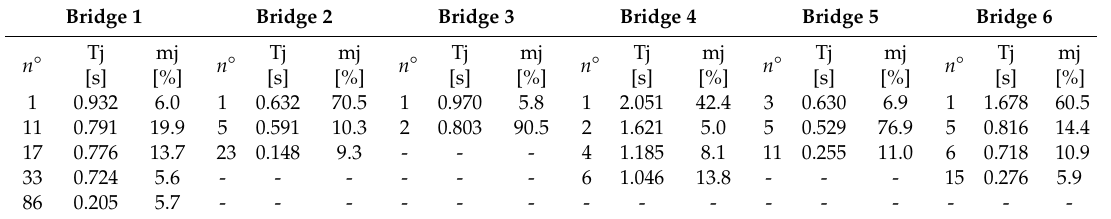
Table 3. Longitudinal vibration Table 4. Transversal vibration modes.